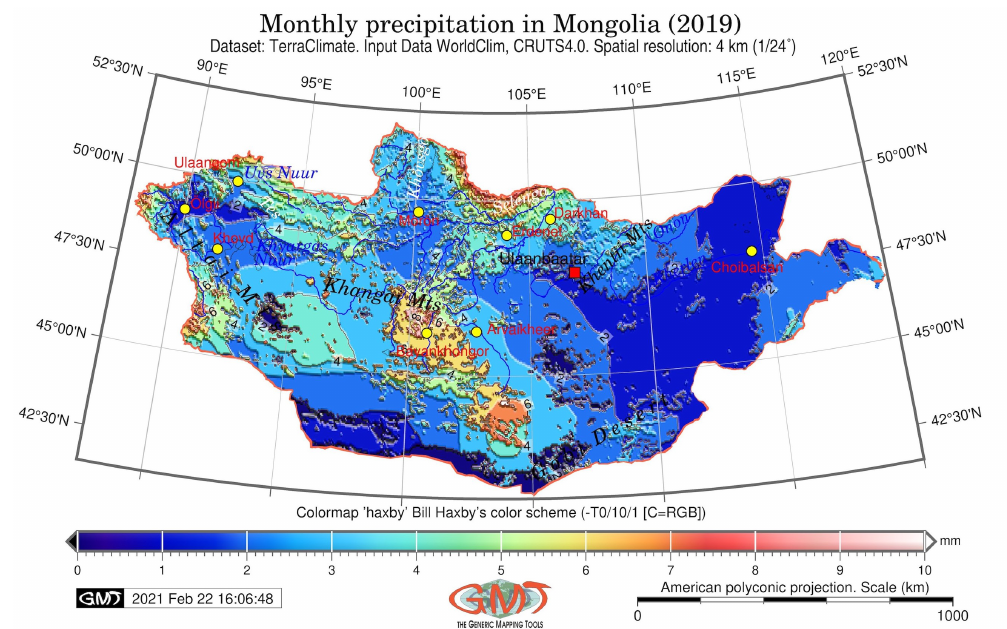
Figure 10. Monthly precipitation in Mongolia in 2019. Mapping: GMT by script available in Appendix B.9. Source: